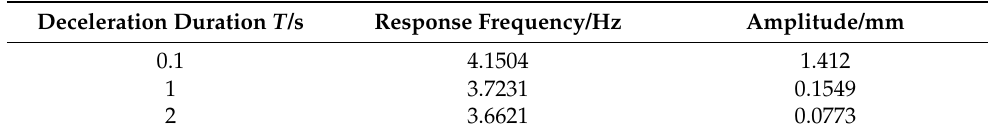
Table 7. Dynamic responses of point A of M3, ω 0 = π /5 (rad/s).